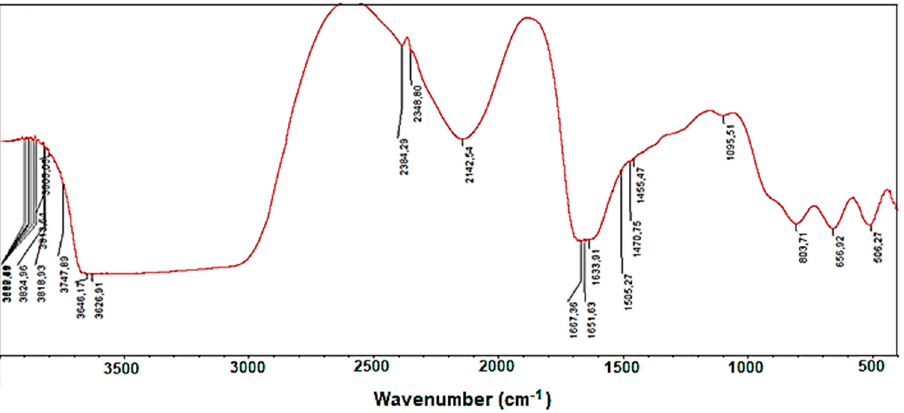
Figure 7. FTIR spectra of mucin secreted by grape snails.